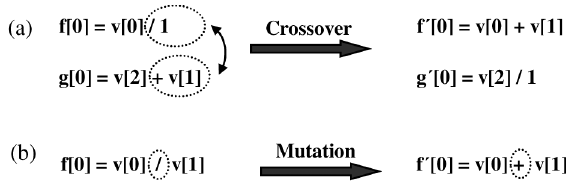
Fig. 4. Typical variation operations in LGP: (a) crossover; and (b) mutation